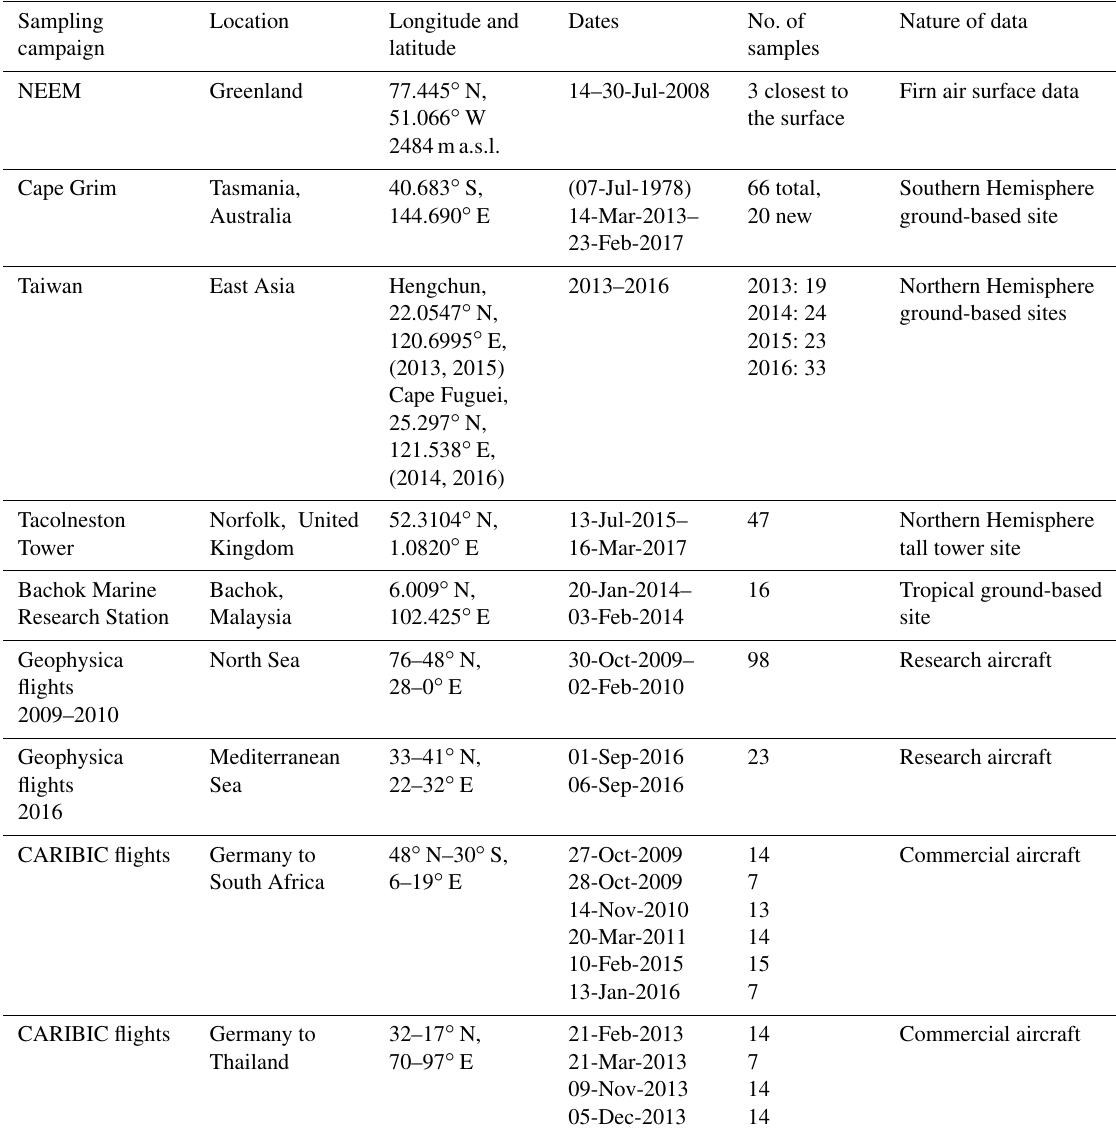
Table 1. Air sampling campaigns from which atmospheric CFC-113a mixing ratios were measured, including the data published in Laube et al.